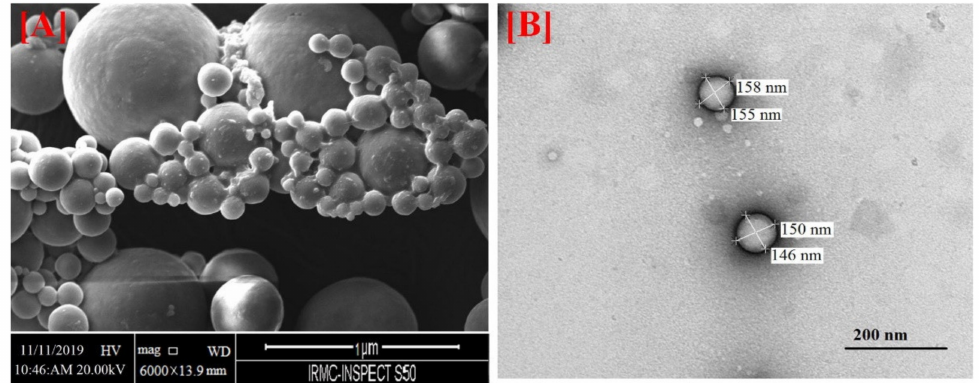
Figure 29. Scanning electron microscopy (SEM) ( A ) and transmission electron microscopy (TEM) ( B ) images of CS-coated-CAT-loaded PLGA NPs [193]. Reproduced with permission from Elsevier